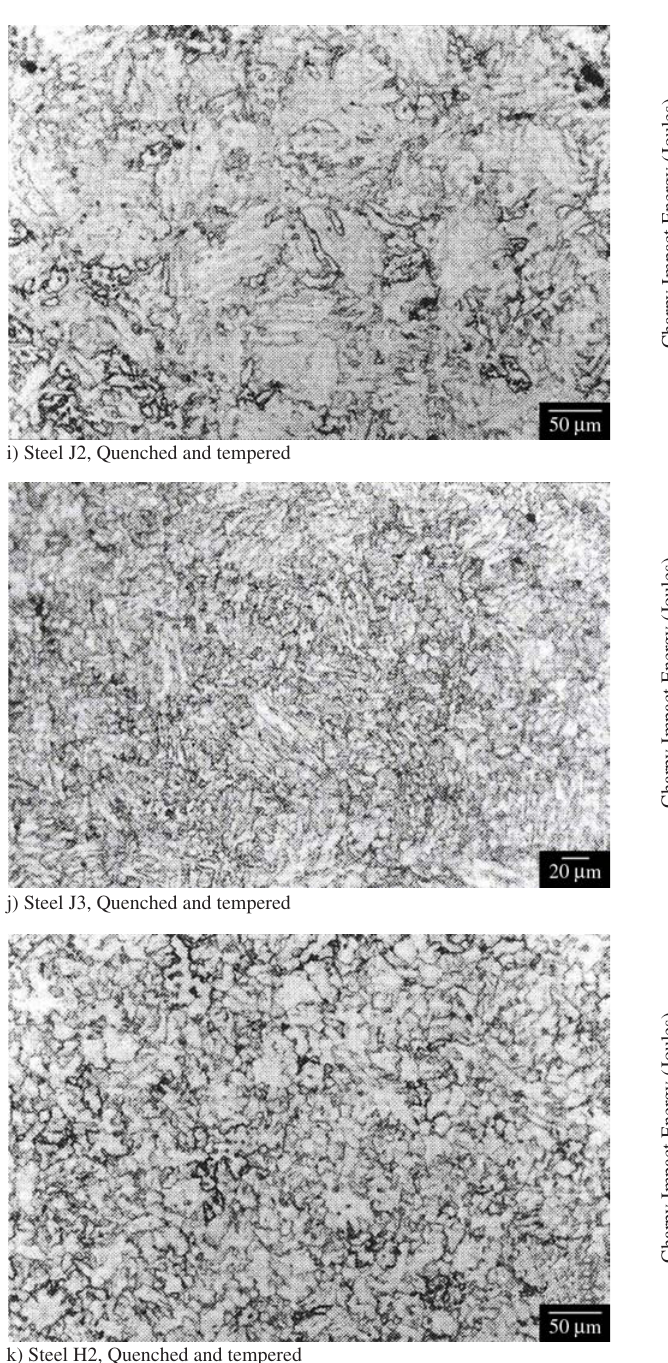
Figure 9. Charpy impact energy versus test